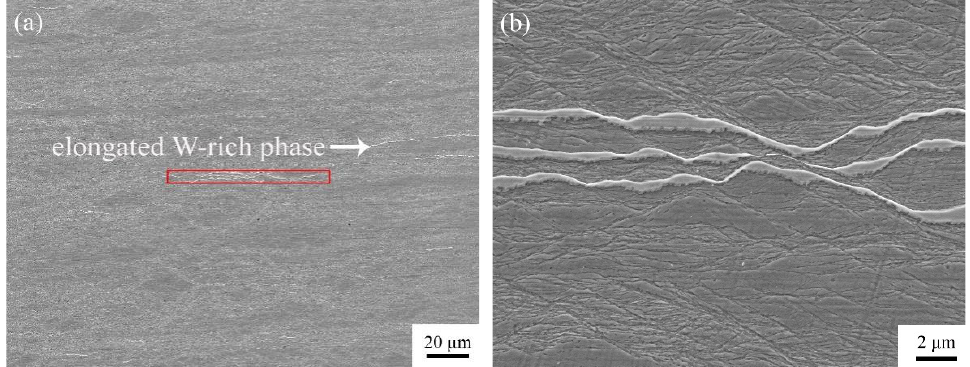
Figure 1. The secondary electron image of sample in ( a ) rolled state, and ( b ) is a large version of the red box in ( a red box in ( a ).